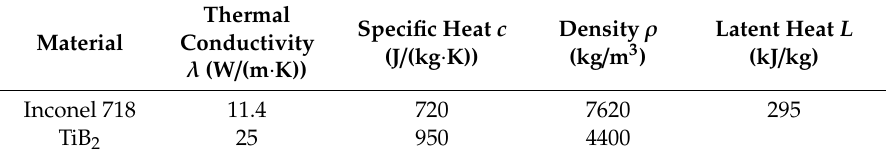
Table 4. Thermal properties of Inconel 718 alloy and TiB 2 particles